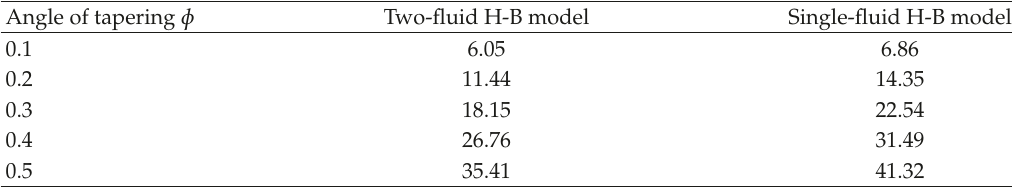
Table 2: Percentage of increase in longitudinal impedance due to the tapering of the artery for two-fluid H-B model and single-fluid H-B model with α (cid:7) 0.95, μ H (cid:7) 0.035, τ m /a (cid:7) 0.0, μ N (cid:7) 0.3 μ H , and τ y (cid:7) 0.1.